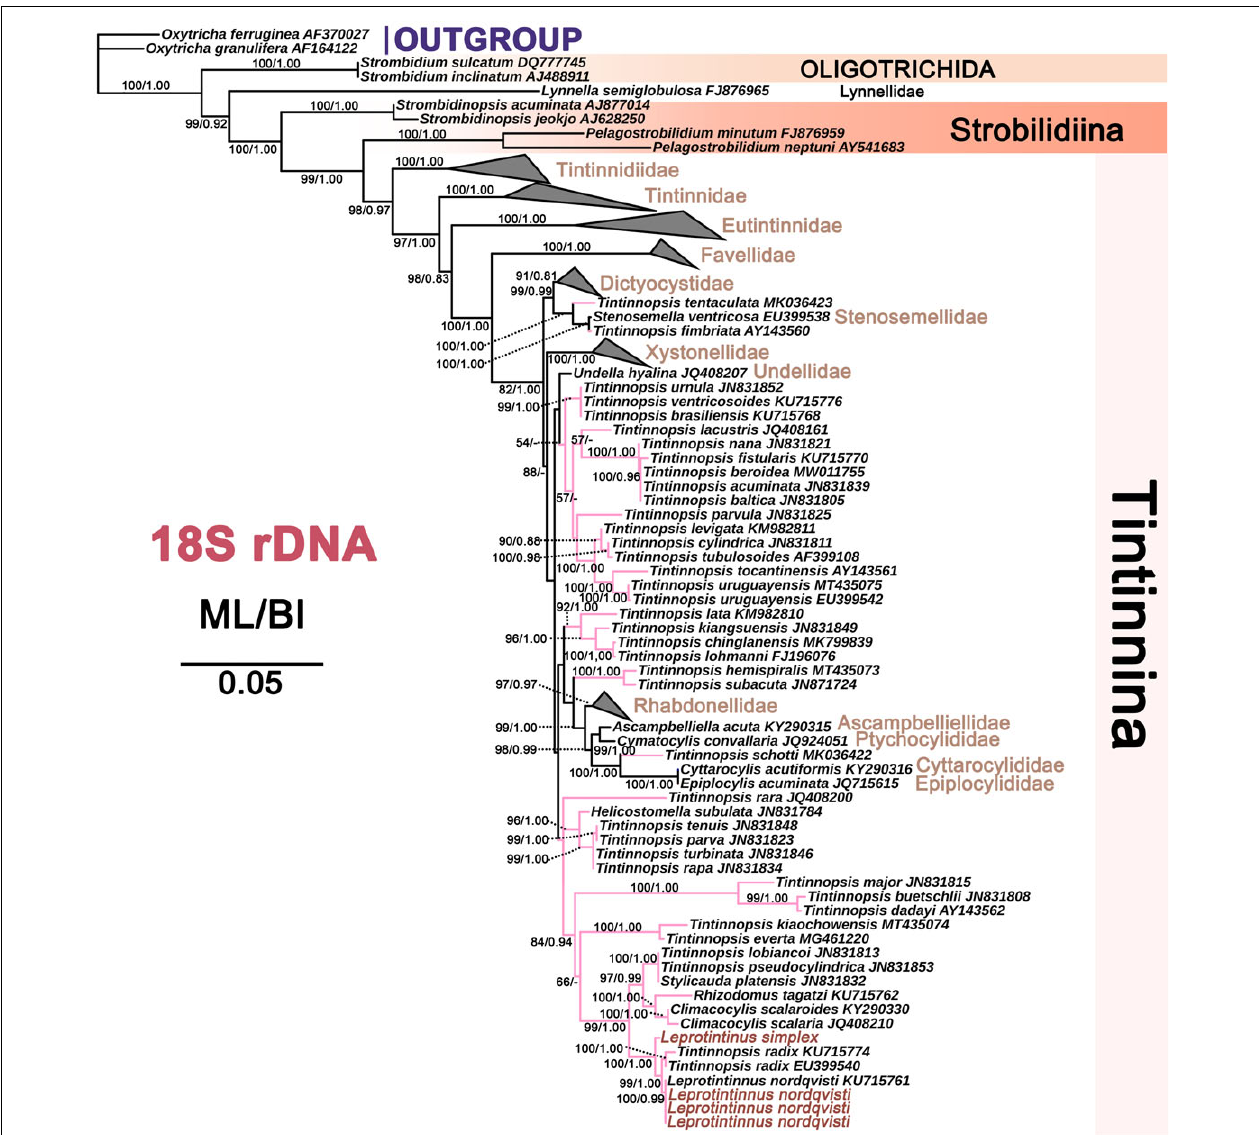
FIGURE 7 | The maximum likelihood (ML) phylogenetic tree is inferred from 18S rDNA sequences. Numbers at the nodes represent support values in the following order: ML and BI bootstrap values. The pink branch denotes the incertae sedis taxa in Tintinnina. The new sequences Leprotintinnus neriticus and L. simplex in the present work were indicated in red. A hyphen (–) represents support values too low (ML < 45%, BI < 0.70) and disagreements in topology between the BI and ML trees. The scale bar corresponds to 5 substitutions per 100